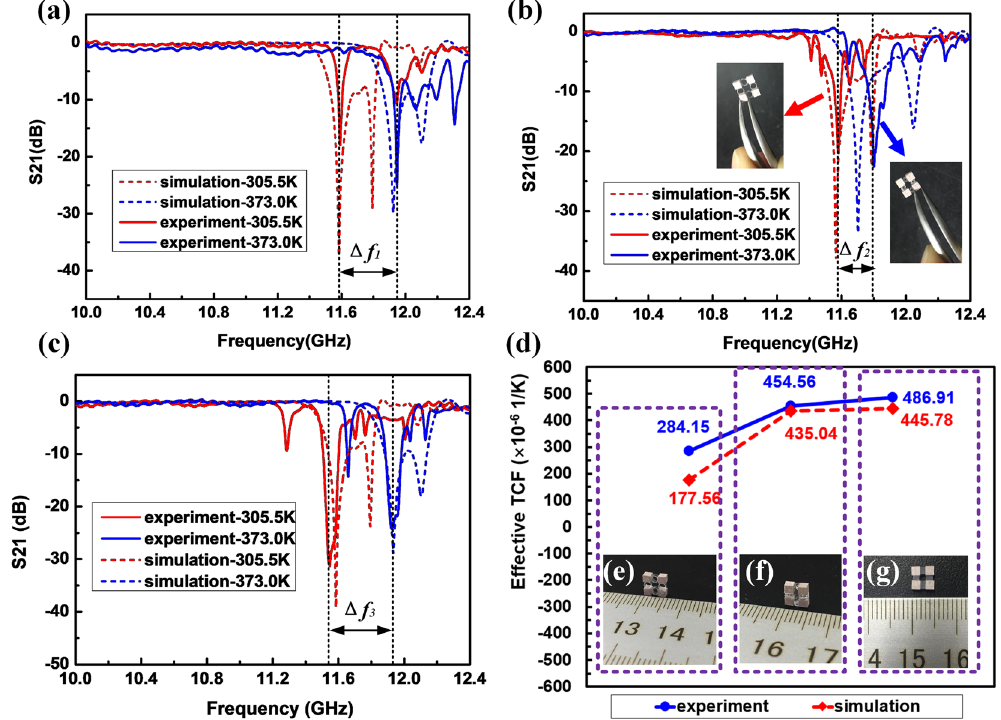
Figure 5. ( a – c ) The simulated and measurement resonance frequency shift of met-atom with intermediate layer of ( a ) silica. ( b ) heat-shrink tubing and ( c ) rubber. ( d ) The comparison of simulated and experiment effective TCF of the three meta-atoms. ( e – g ) Photos of the fabricated meta-atom samples. From left to right these are the heat shrink tubing layer, the silica layer, and the rubber layer. Photo insets in ( b ) show the initial shape (red arrow) of the meta-atom sample with heat-shrink tubing layer and its deformed shape (blue arrow) after